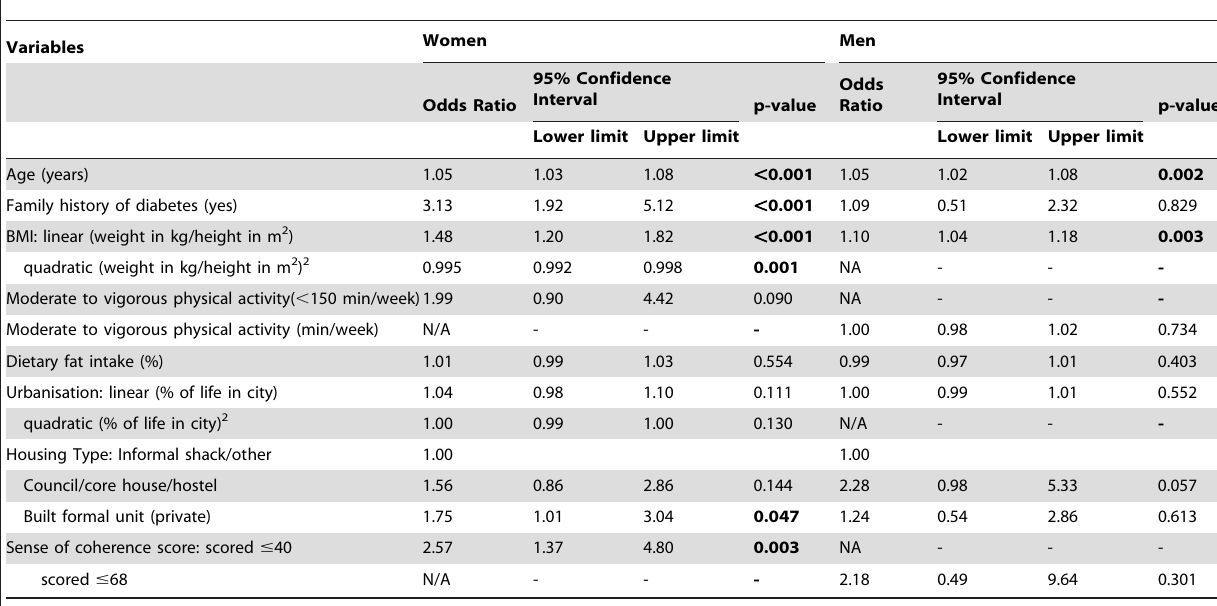
Table 4. Multiple logistic regression model for associations with diabetes in women and men